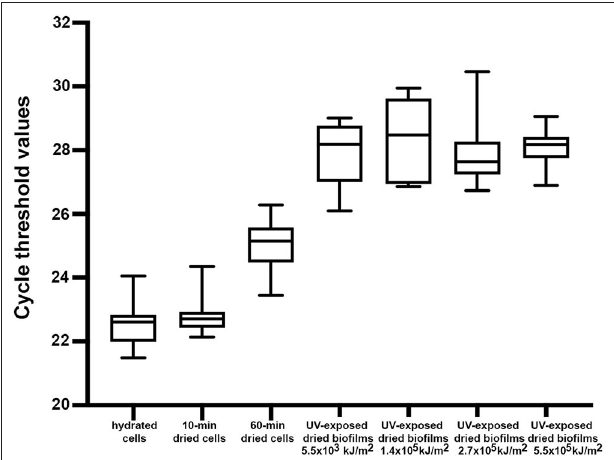
FIGURE 2 | Permanence of 16S rRNA in 10- and 60-min dried Chroococcidiopsis cells and in 7-year dried Chroococcidiopsis biofilms mixed with P-MRS, according to Ct values in the RT-qPCR assay. Samples: hydrated control cells; 10- and 60-min dried cells; 7-year dried biofilms mixed with P-MRS and exposed to increasing Mars-like UV radiation doses. Ct values are shown as medians (lines), 25th percentile to 75th percentile (boxes), and ranges (whiskers).